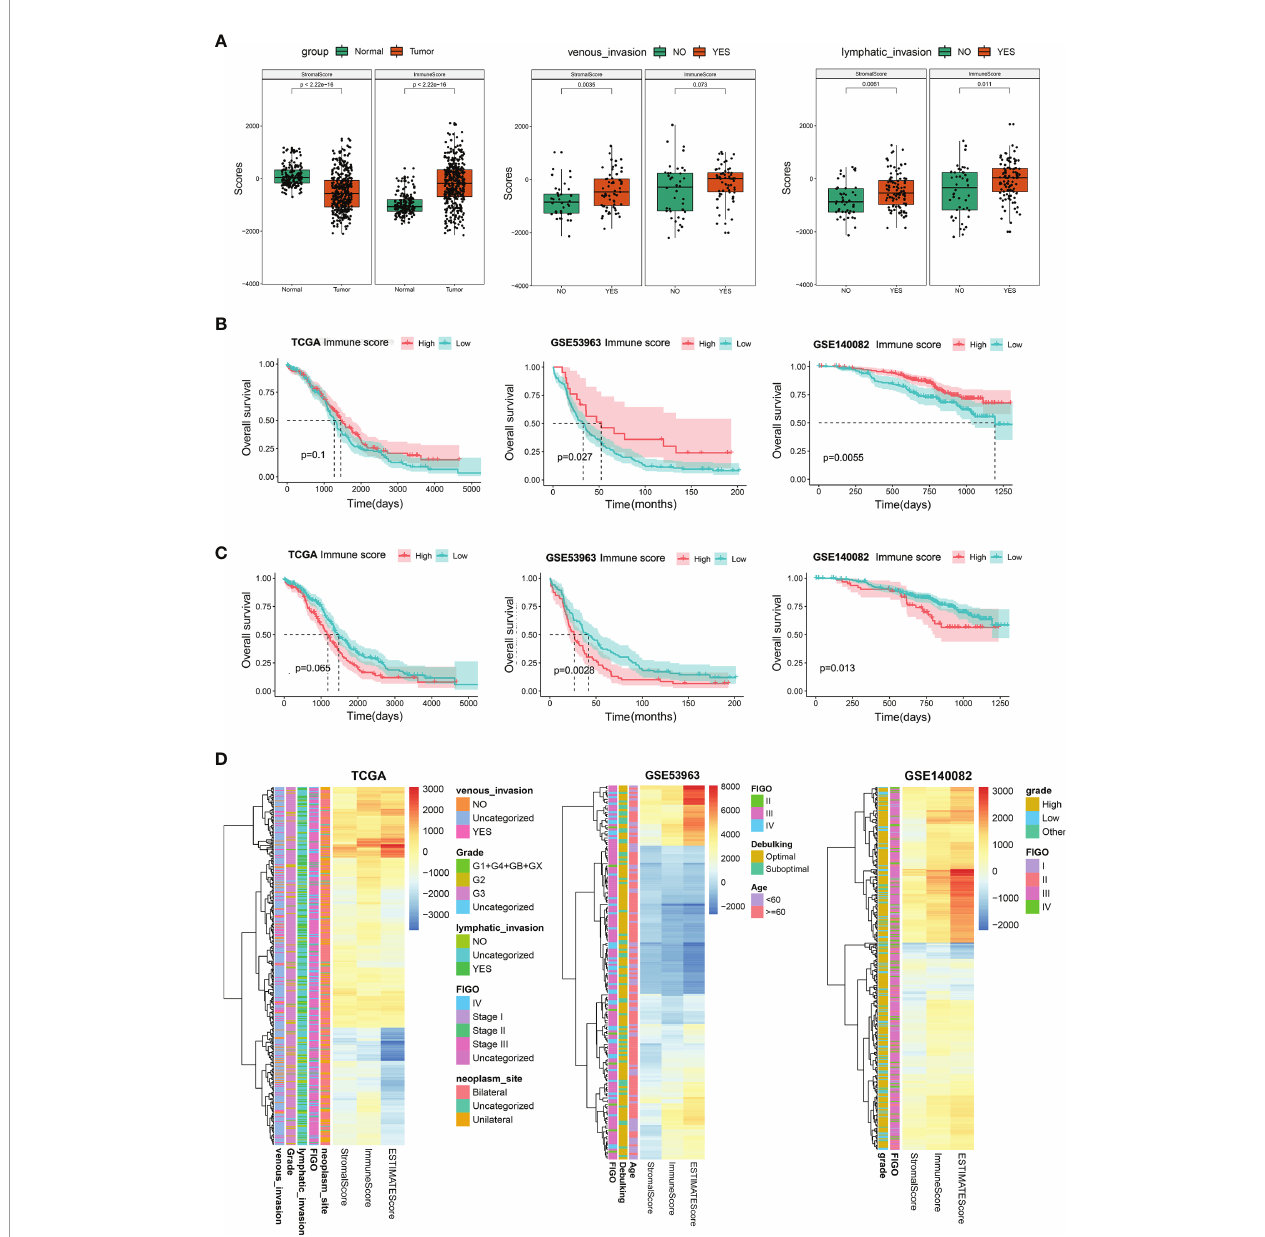
FIGURE 2 | Stromal and immune scores and their relationship with patients ’ clinical characteristics. (A) Differential analysis for the distribution of stromal and immune scores in tumor and normal tissues; in venous/lymphatic invasion and non- venous/lymphatic invasion in the tumor. (B) Survival analysis premised on the high- and low-immune scores in the TCGA, GSE53963, and GSE140082 databases. (C) Survival analysis premised on the high- and low-stromal scores in the TCGA, GSE53963, and GSE140082 databases. (D) Heatmap of immune, stromal, and ESTIMATE scores in TCGA, GSE53963, and GSE140082